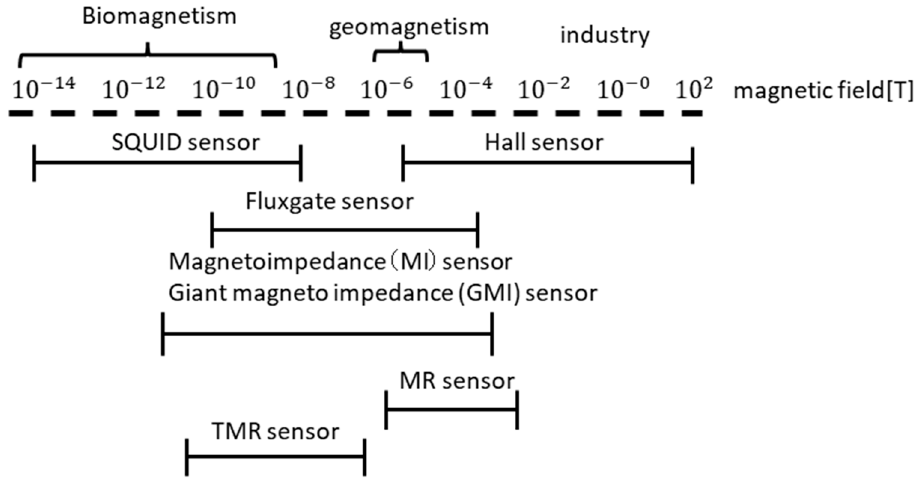
Figure 1. Relationship between magnetic sensors and measurable magnetic flux densities.